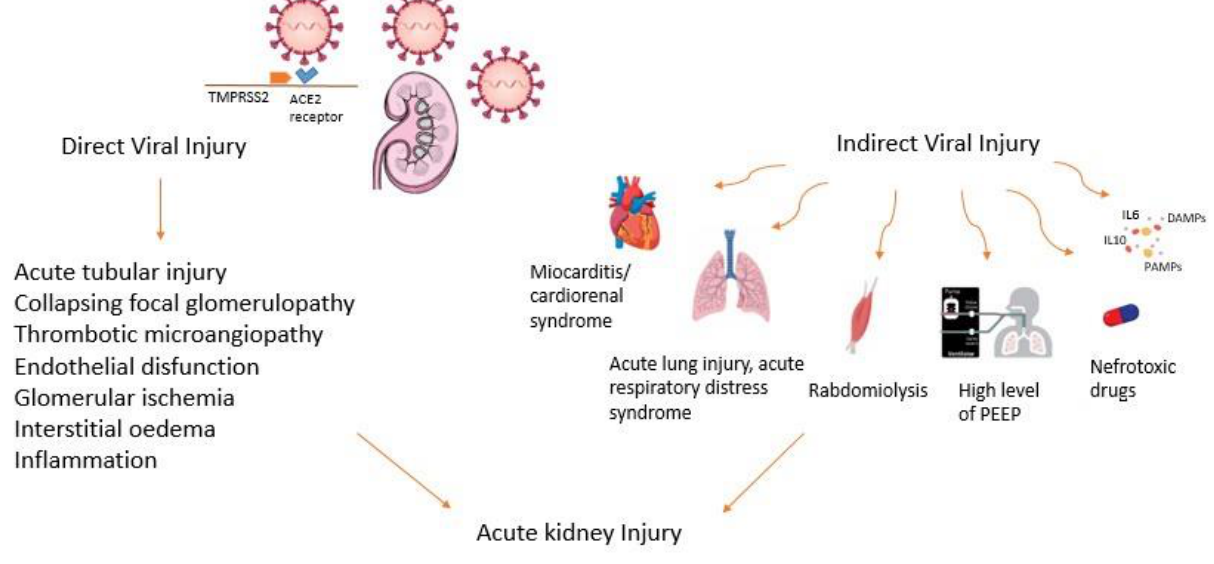
Figure 1. Direct and indirect effects of SARS-CoV-2 infection on the pathophysiology of